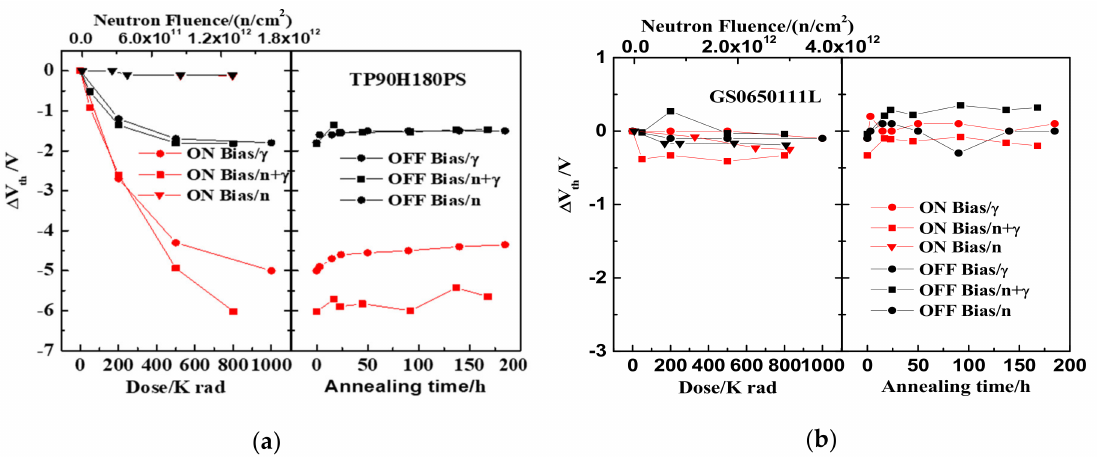
Figure 6. The variations of threshold voltage with the neutron and gamma-ray irradiation and 168 h annealing under the on-state and off-state: ( a ) TP90H180PS and ( b )